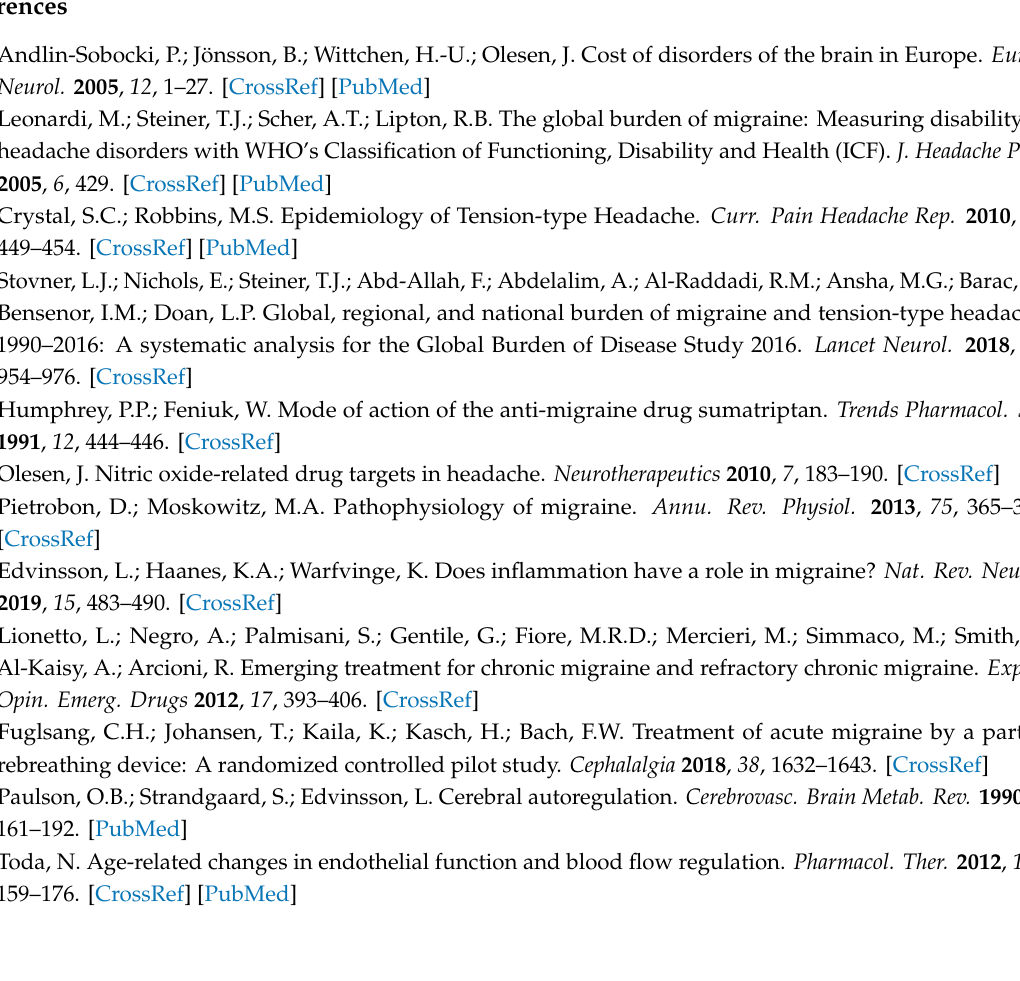
Table S1: Animal studies of L-arginine on vascular tone, Table S2: Human studies of L-arginine on vascular tone, Table S3: Animal studies of AGE on vascular tone, Table S4: Human studies of AGE on vascular tone, Table S5: Currently commonly used approaches to treat